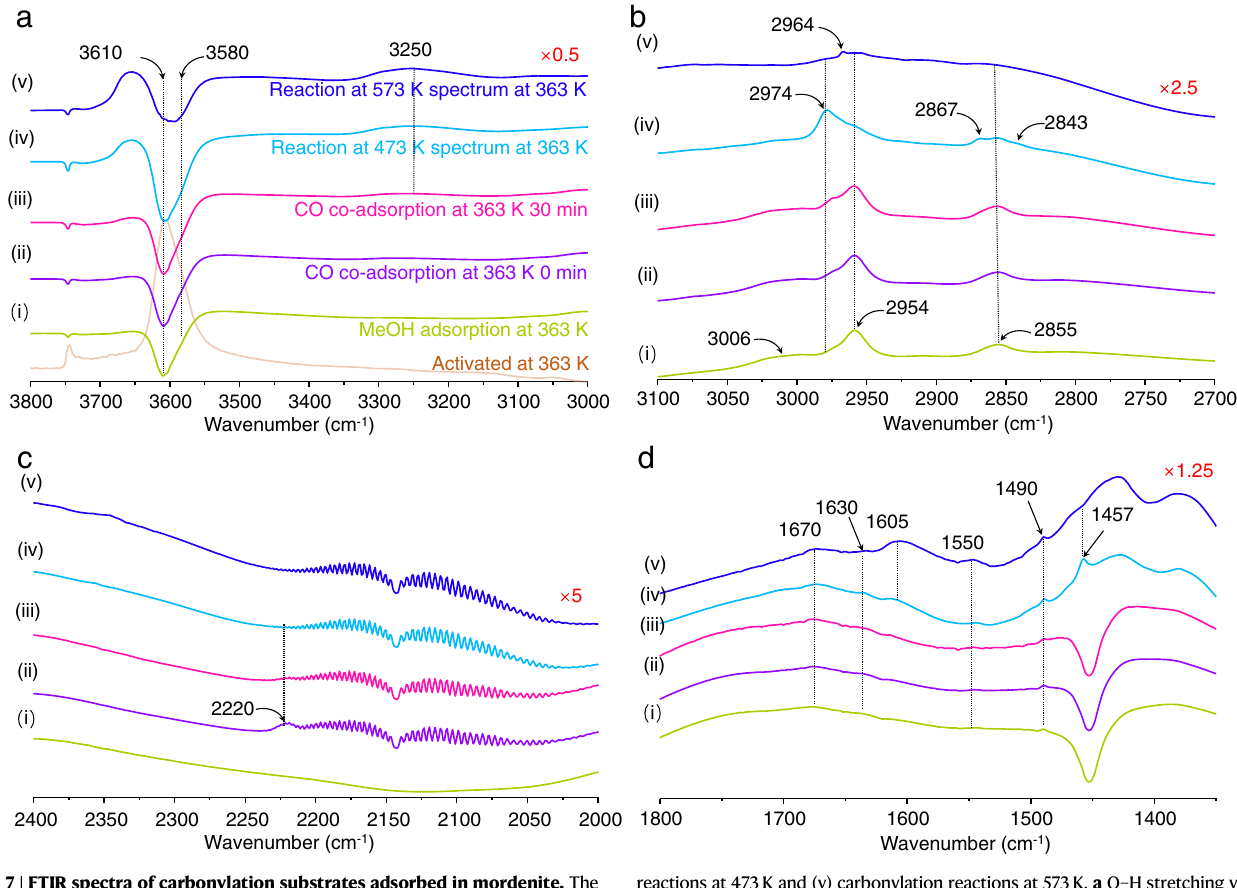
reactions at 473K and (v) carbonylation reactions at 573K. a O – H stretching vibra- tions: 3800 – 3000cm − 1 , b C – H stretching vibrations: 3100 – 2700cm − 1 , c C ≡